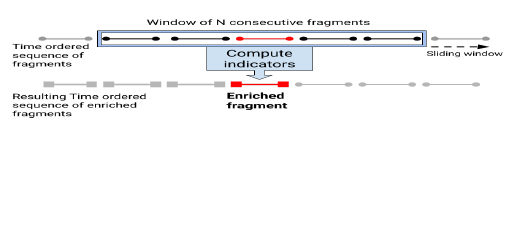
Figure 10 . Schematic of processing using time convolution over